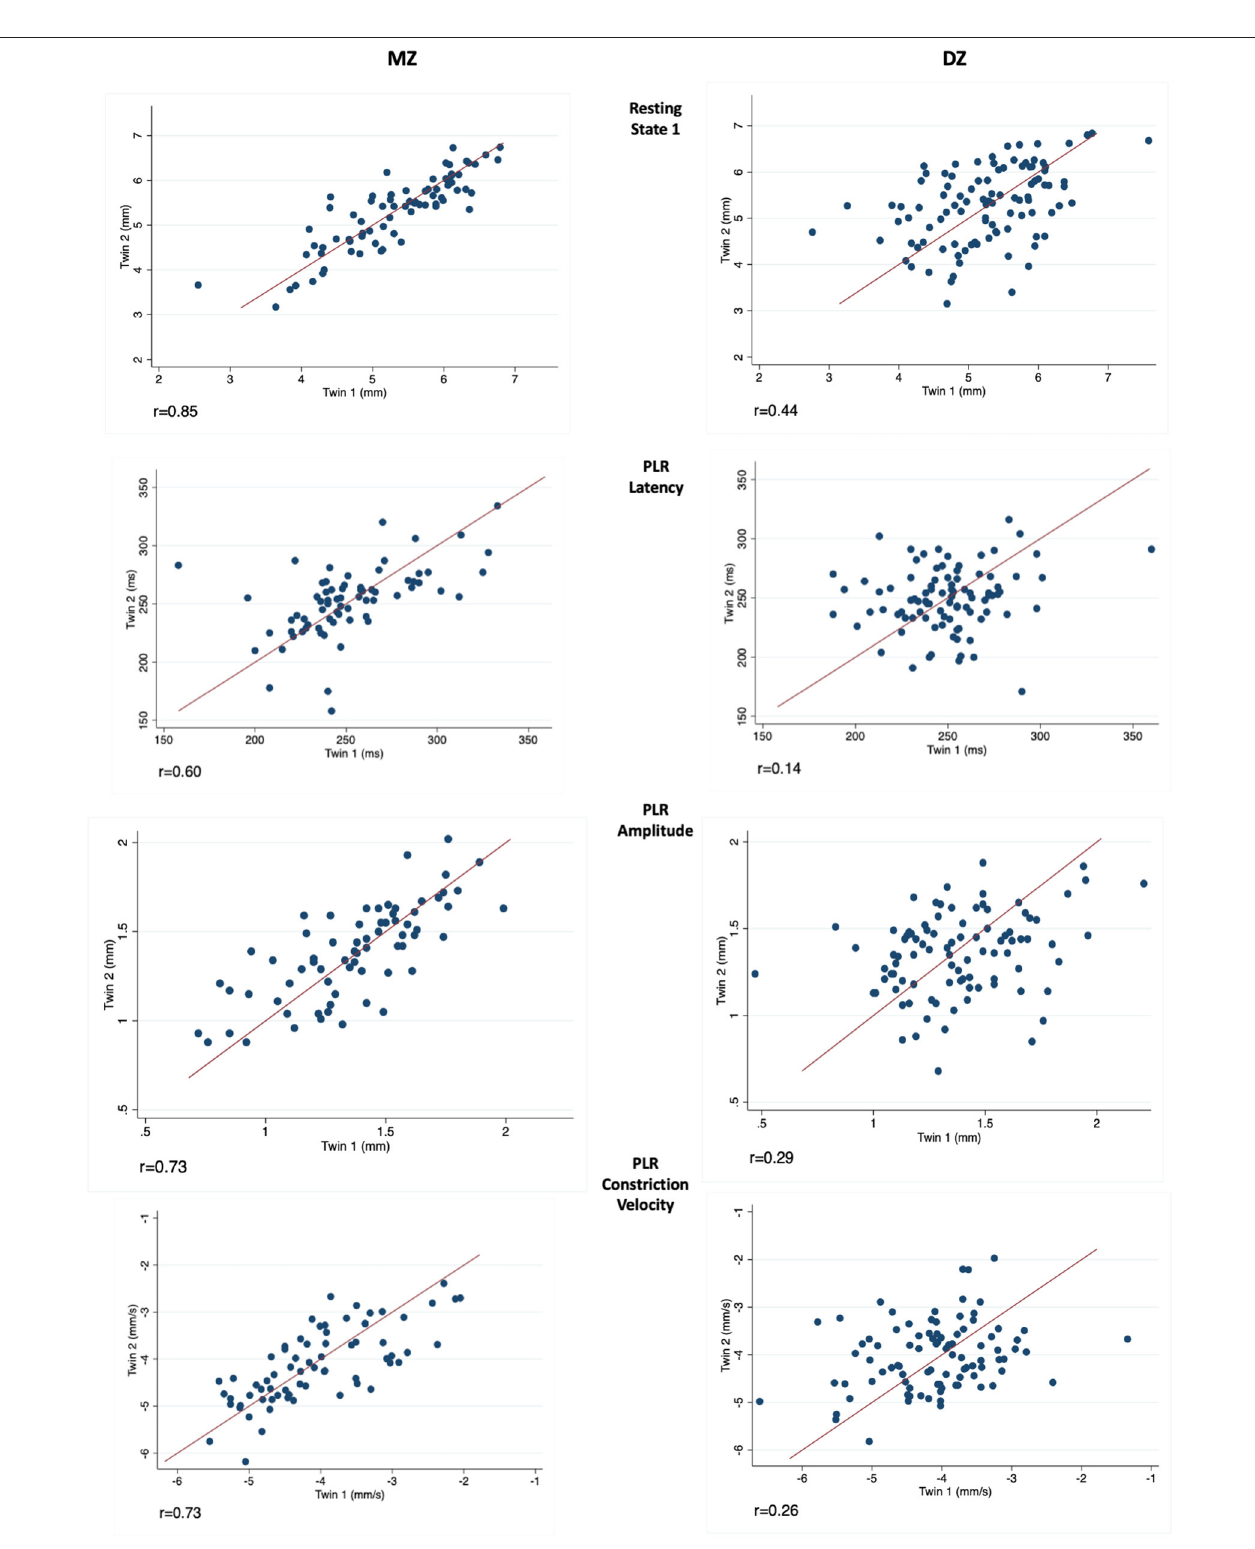
FIGURE 2 | Measurements in twin pairs (twin 2 plotted against twin 1) for resting state 1 (Top), PLR latency, amplitude and constriction velocity (Bottom). Monozygotic (MZ) twin pairs are on the left and Dizygotic (DZ) on the right. Correlation coefficient ( r ) is given below for each parameter investigated.